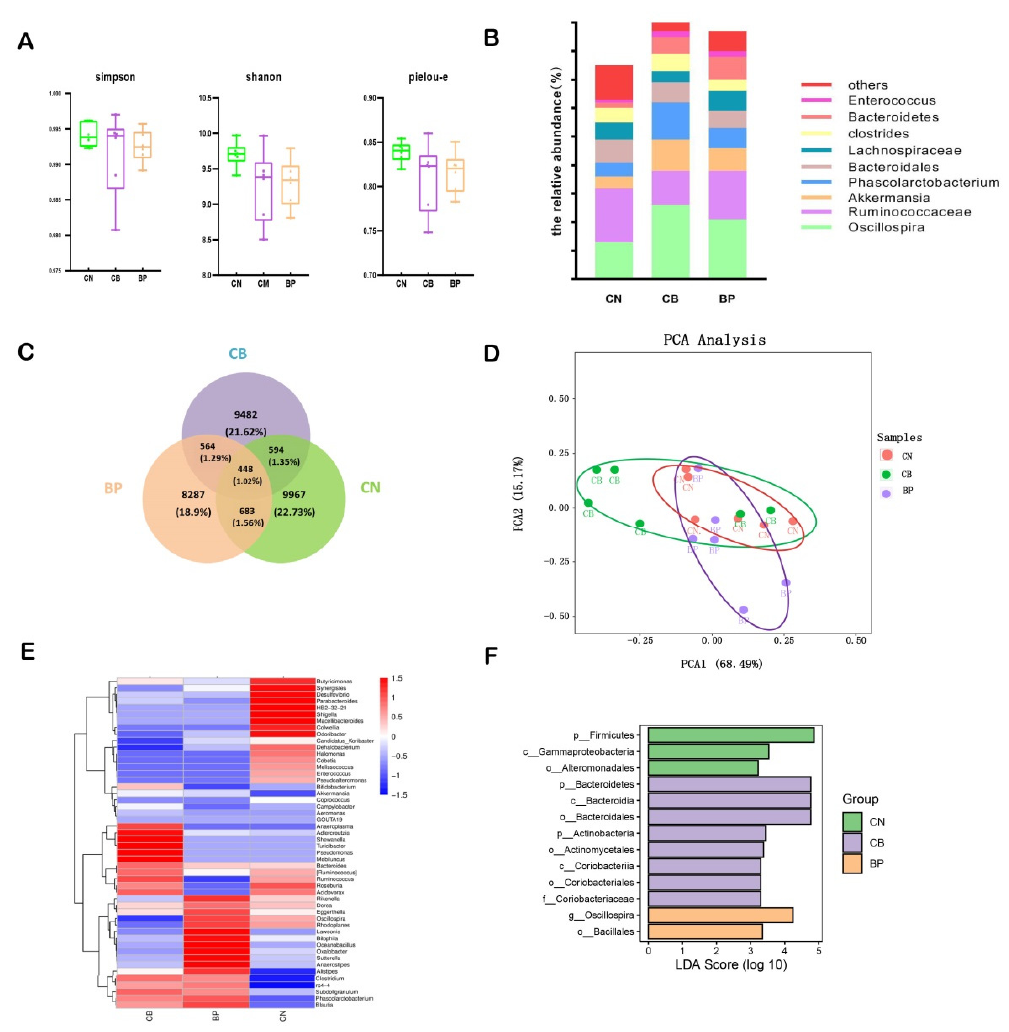
Figure 7. Summary of the microbial community in the cecum contents of rabbits. ( A ) Simpson, Shannon, and Pielou-e indexes of α diversity. ( B ) The relative abundance of the top 20 genera classified as rectal microbiota constituents. ( C ) A Venn diagram summarizing the numbers of common and unique operational taxonomic units (OTUs). ( D ) Nonmetric multidimensional scaling (NMDS) analysis. ( E ) Species composition heat map at the genus level for species clustering. The red color blocks represent genera that were more abundant in that sample than in other samples, and the blue color blocks represent genera that were less abundant in that sample than in other samples. ( F ) Histogram of linear discriminant analysis (LDA) effect values by marker species, from phylum to species in this graph, that were statistically significant ( p < 0.05) and had an LDA score > 2. CN, rabbits were fed a basal diet; CB, rabbits were fed a basal diet supplemented with Clostridium butyricum ; BP, rabbits were fed a basal diet supplemented with a bacteriophage cocktail (two samples failed to pass the quality inspection, thus n = 6).